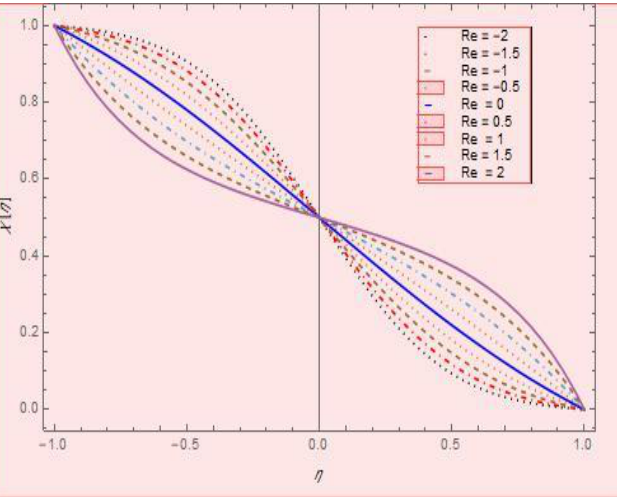
Figure 4. Concentration profiles for ϕ 1 = ϕ 2 = 0.01, α = 1, M = 1, Re = 1, Pr = 6.2.